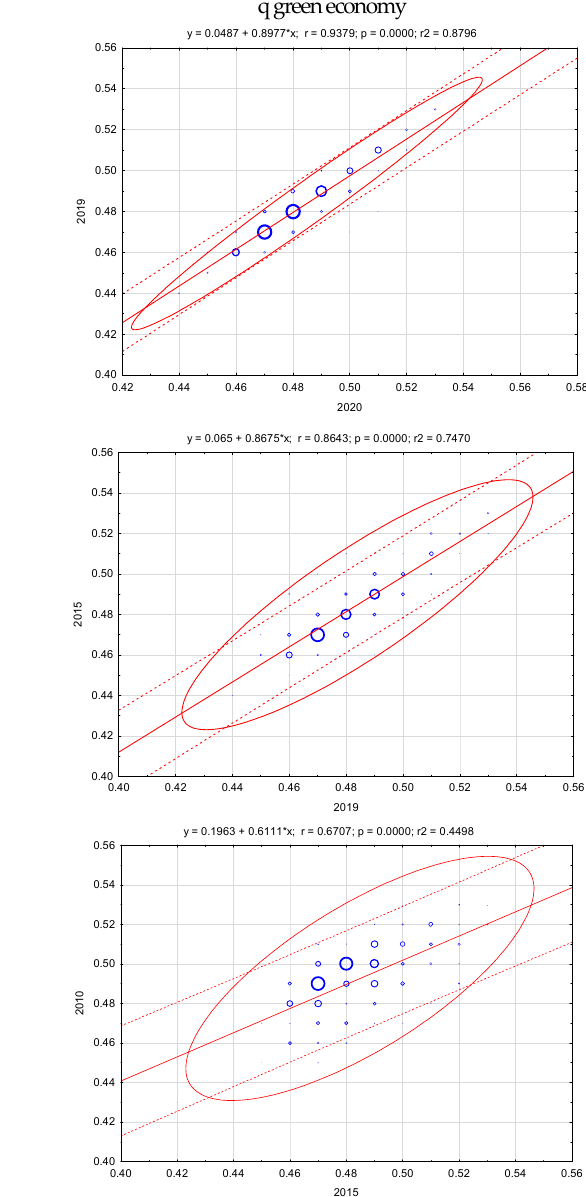
Figure 4. Distribution diagram of the synthetic measure, waste management and green economy in districts in Poland (in 2010, 2015, 2019, and 2020). Source: Own study. Scatterplot analysis shows what kind of relationship we are dealing with (positive or negative). This allows for the indication of groups of objects with similar values of the examined criterion, the indication of outliers (statistically distinct), and the indication of regularity (or irregularities) in the data set. The Pearson correlation coefficient between the value of the synthetic measure in the year-on-year report is shown in Figure 5. Higher correlation indicators in the year-on-year report are observed in the case of the green economy measure (the ratio of 2010 to 2015 and is 0.670; the ratio of 2020 to 2019 and is 0.937), lower for waste management (the ratio of 2010 to 2015 and is 0.301; the ratio of 2020 to 2019 and is 0.803).